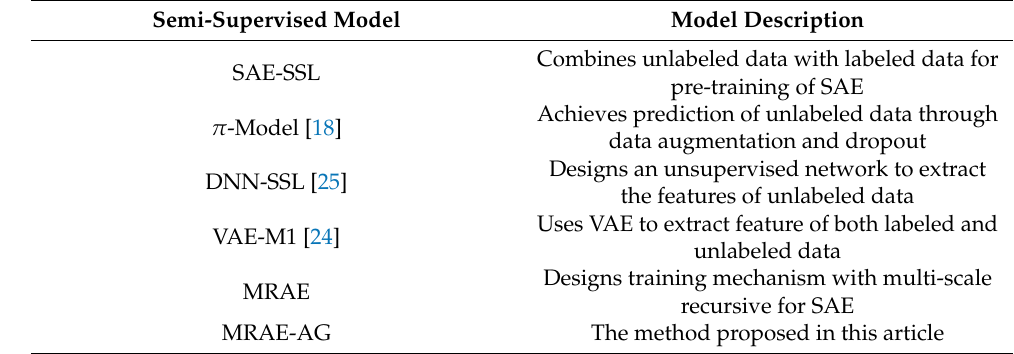
Table 2. The related semi-supervised models for comparison.